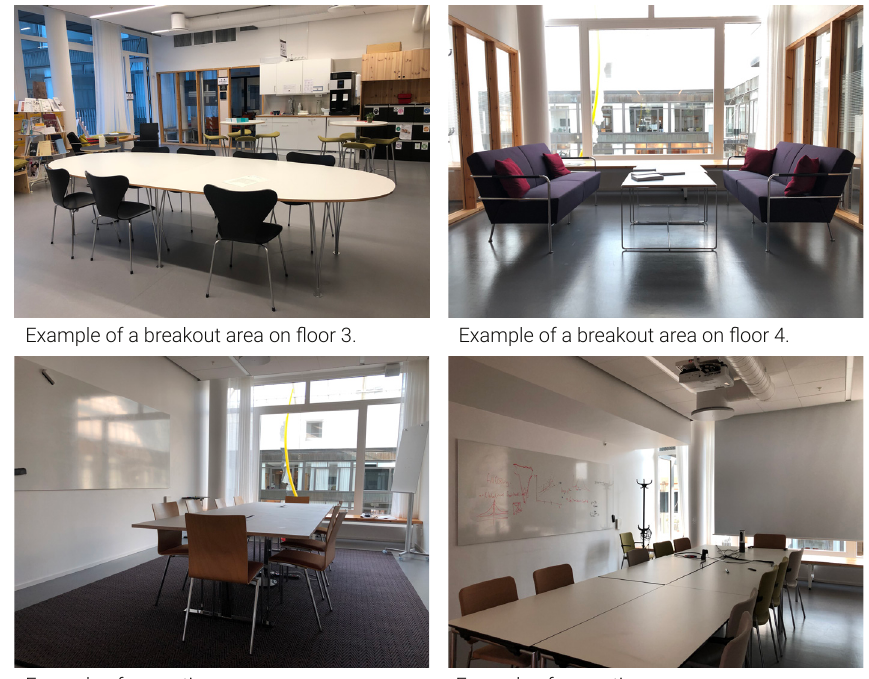
Figure 12. Social connections and